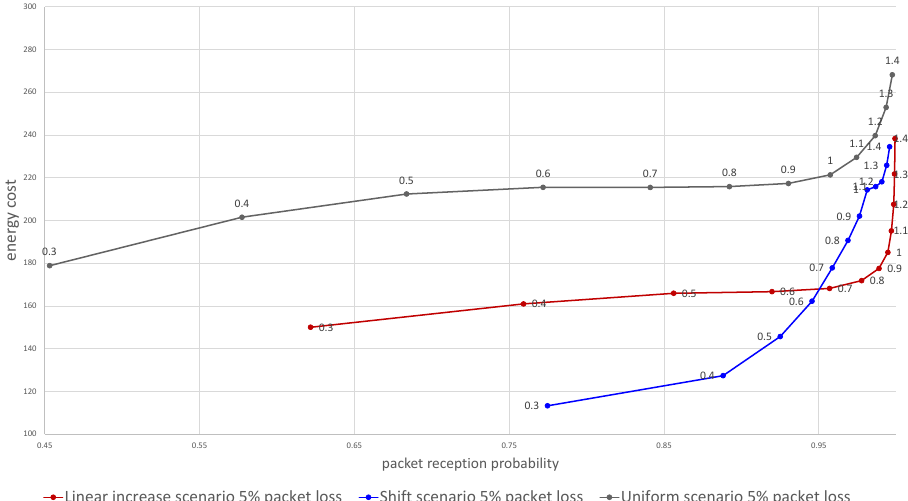
Figure 5. Dependence of the energy cost on the probability of packet delivery for the two proposed algorithms in comparison with using constant size time window. Numbers above data points denote α